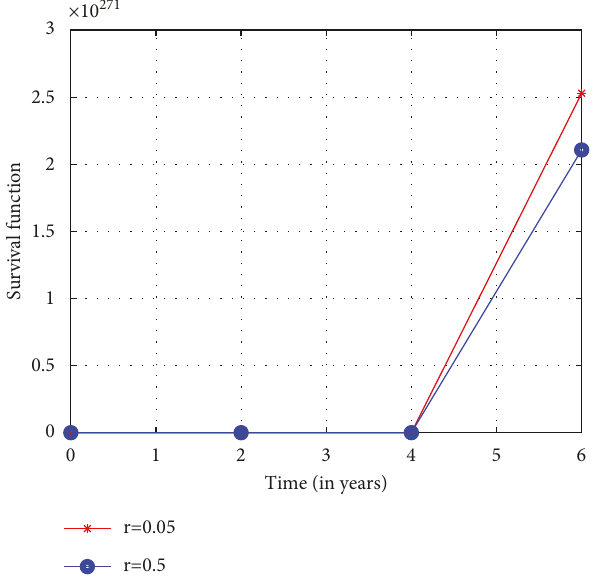
Figure 2: Dependence of the survival function on the instanta- neous rate of stock return.